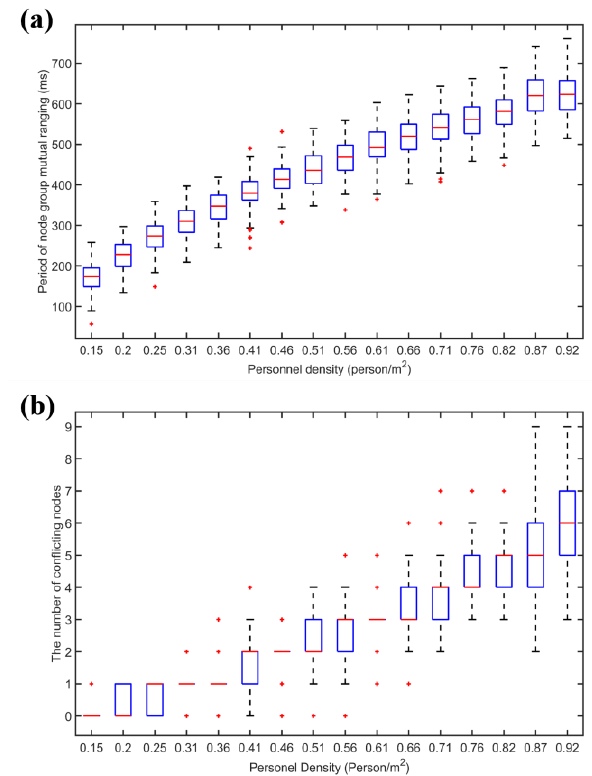
Figure 29. CSMA/CA channel access simulation results. ( a ) The total period of node cluster mutual ranging under hybrid channel access. ( b ) The number of nodes colliding with hybrid channel access. In the case of different numbers of nodes (node density), 100 simulations were carried out, respectively, and the node group mutual ranging period and the number of nodes colliding were obtained under the hybrid channel access method.The results are shown in Figure 30.